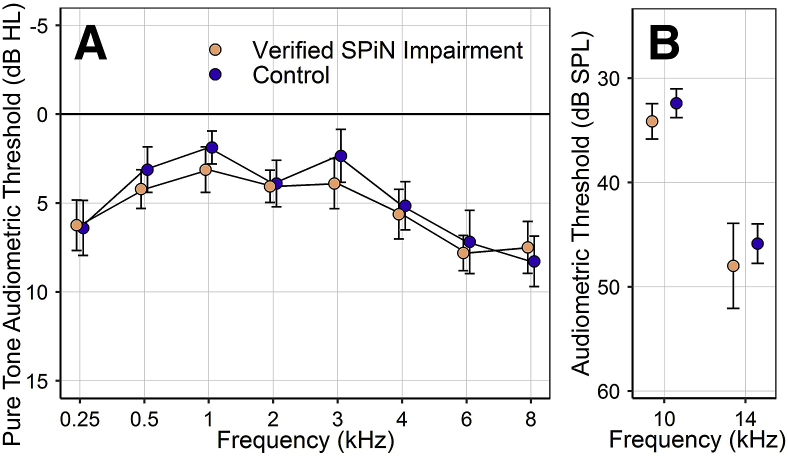
Mean audiometric thresholds for the verified-SPiN-impairment and control groups. Error bars represent the standard error of the mean (SEM). A: Pure-tone audiometric thresholds. Group means differ by < 2 dB. B: EHF audiometric thresholds for 1/3-octave narrowband noise. Group means differ by 1.7 dB at 10 kHz and 2.1 dB at 14 kHz.